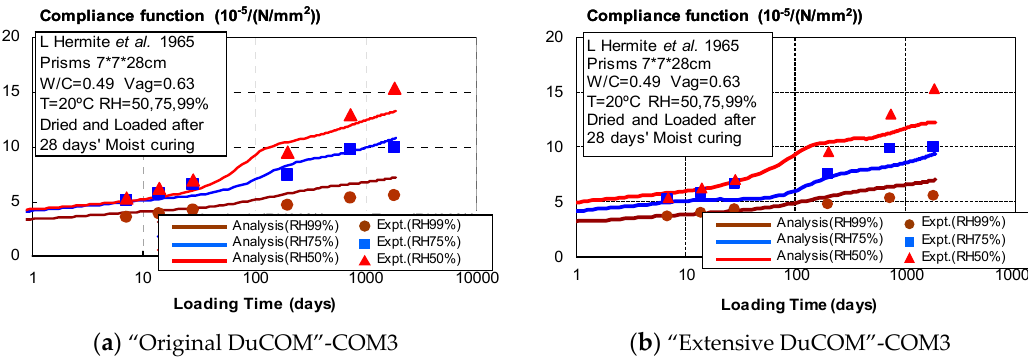
Figure 26. Comparison of drying creep under different relative humidity at 20 °C [31].